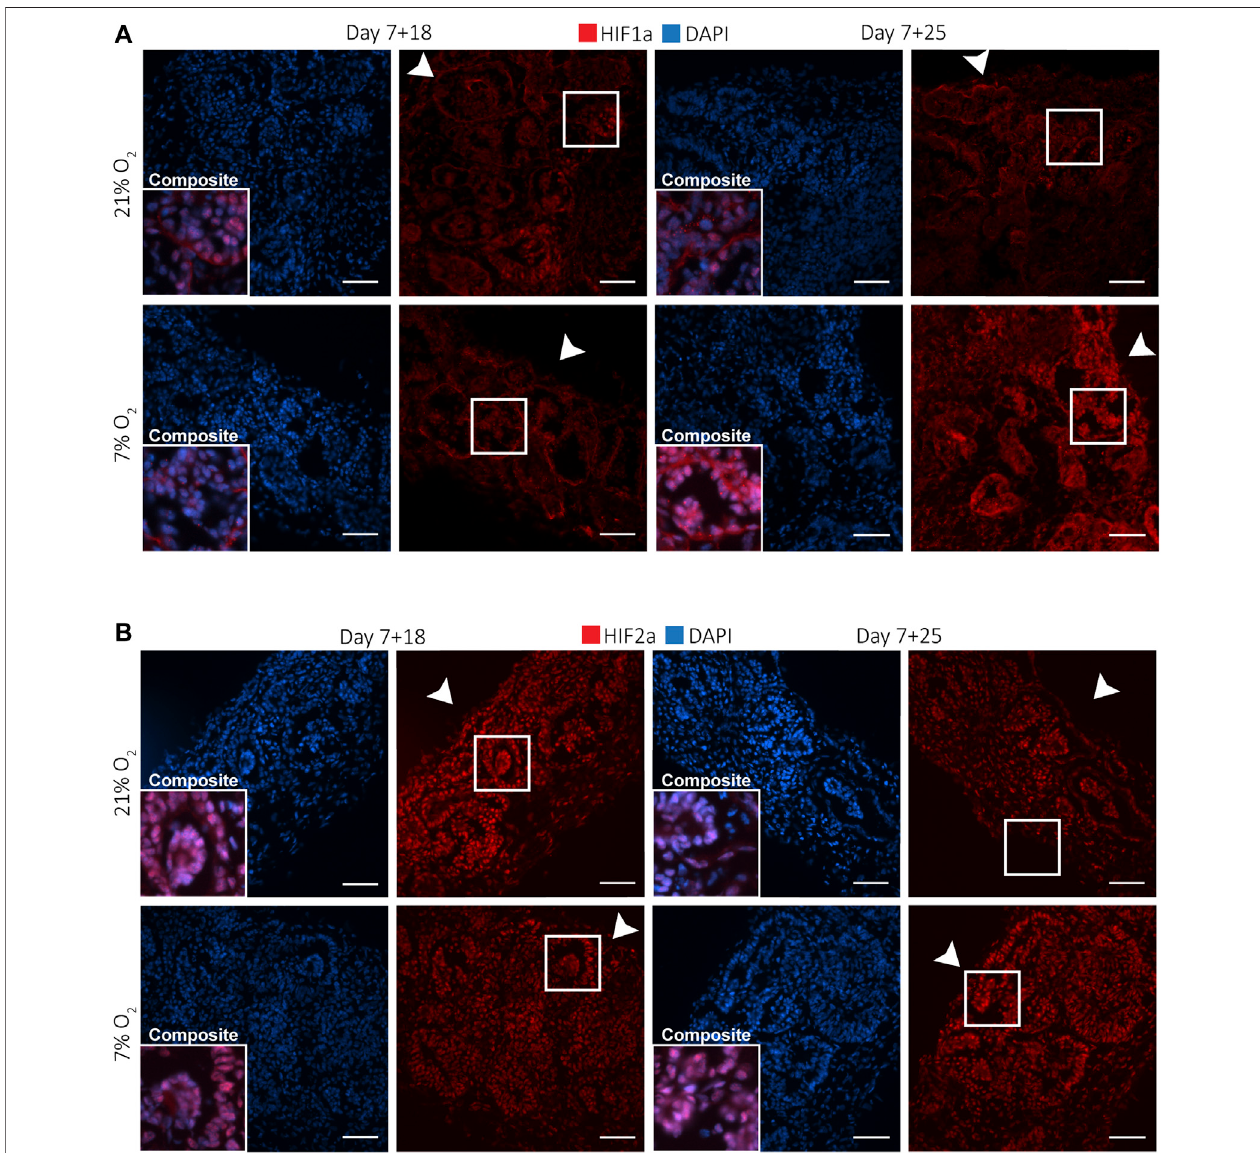
FIGURE 3 | Kidney organoids cultured in both 7 and 21% O 2 show differential nuclear translocation of HIF1a and HIF2a. (A) . Immuno fl uorescence staining for HIF1a (red) and DAPI (blue) shows increased nuclear translocation in podocytes (composite), particularly in 7% O 2 at day 7 + 25. Scale bar: 50 µm. (B) . HIF2a (red) and DAPI (blue)immuno fl uorescencestainingshows nuclear translocation inmostcellswithintheorganoid irrespective oftheoxygenconcentrationor timepoint. ( n =3, N = 3). Scale bar: 50 µm. Arrowheads indicate the (air-exposed) surface of the organoids.